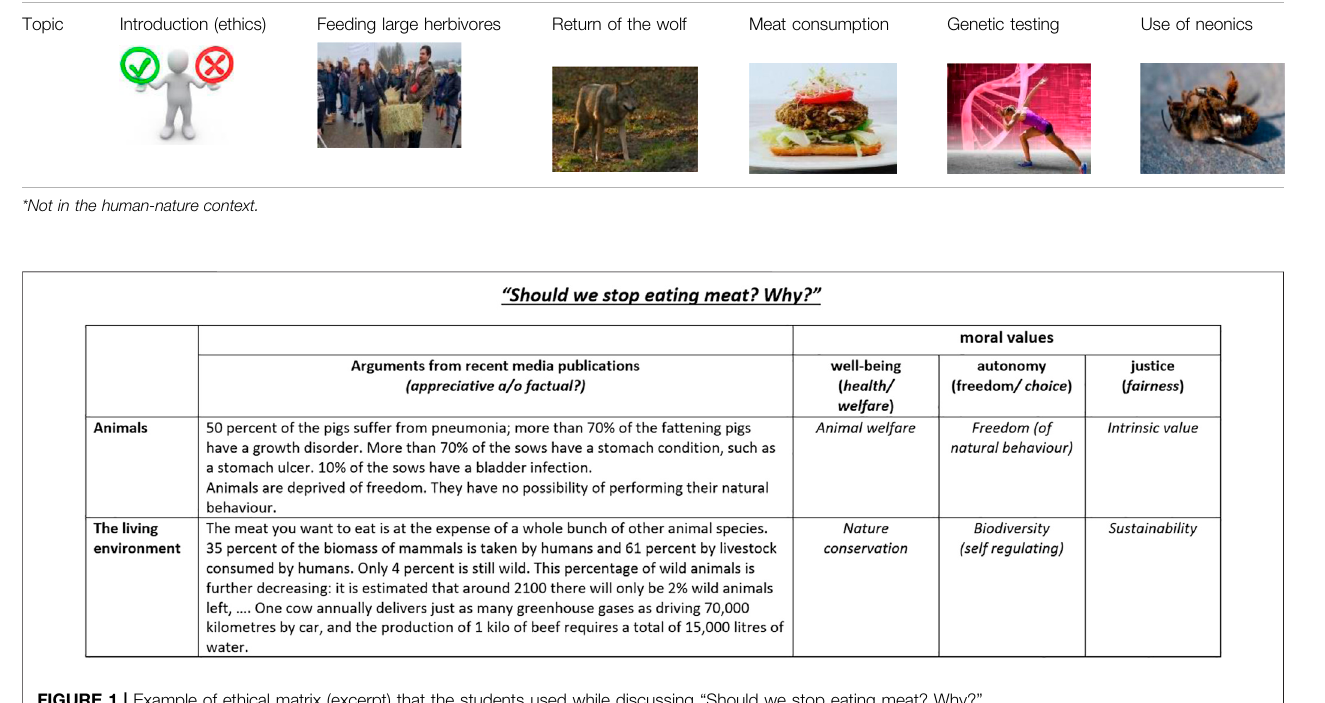
TABLE 1 | Overview of the implemented course: Introductory lesson and the addressed moral dilemmas.